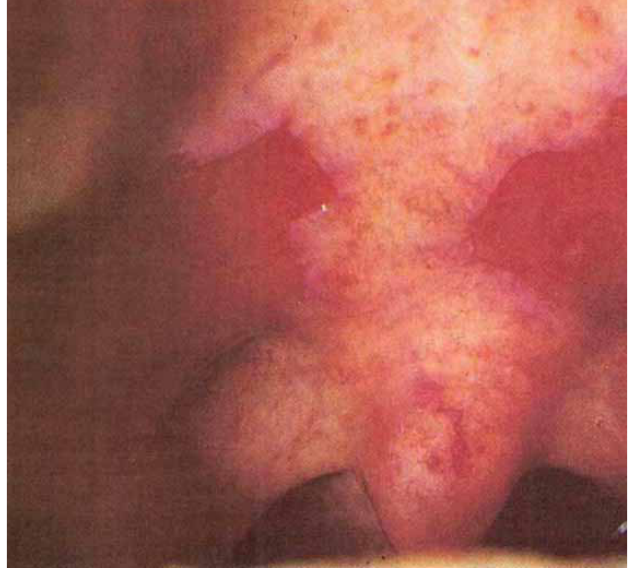
Fig. 1: Pemphigus vulgaris oral lesion (palatal mucosa)